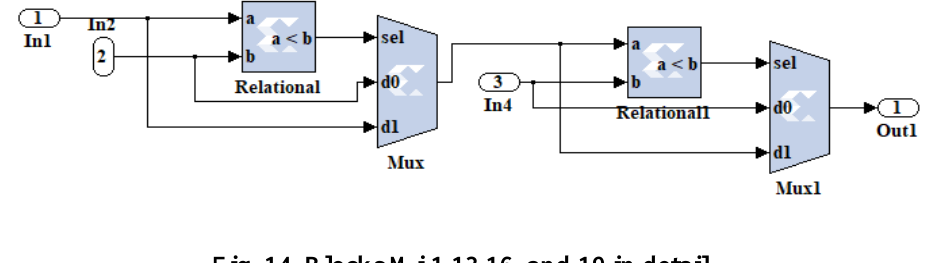
Fig. 14. Blocks Mi 1,13,16, and 19 in detail.